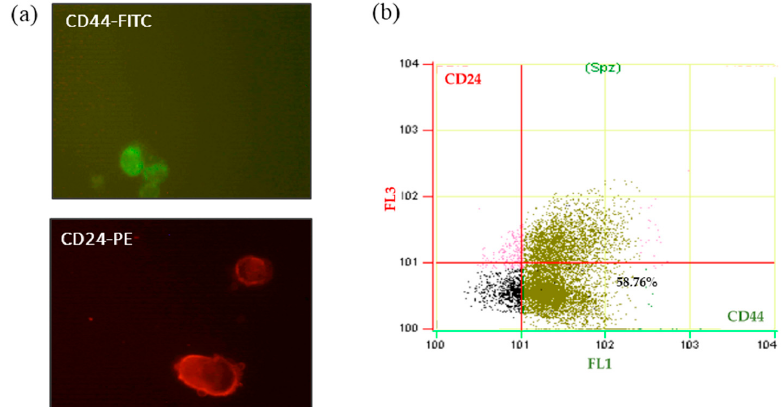
Figure 7. Expression of CD44 and CD24 cell surface markers on MCF7 2D cultured cells. ( a ) Confocal microscopy images of MCF7 cells marked with antibody CD24 and CD44 ( Green : CD44-FITC; Red : CD24-PE); ( b ) flow cytometric analysis of CD24 and CD44 surface markers in MCF-7 cells from 2D culture system. Abbreviations: FITC, fluorescein isothiocyanate; PE, phycoerythrin.